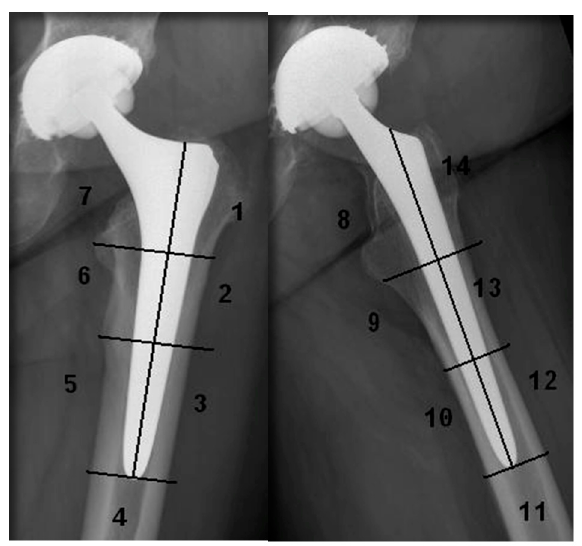
Figure 2. Radiolucent lines classified in Gruen zones (ap. 1-7, lat. 8-14).